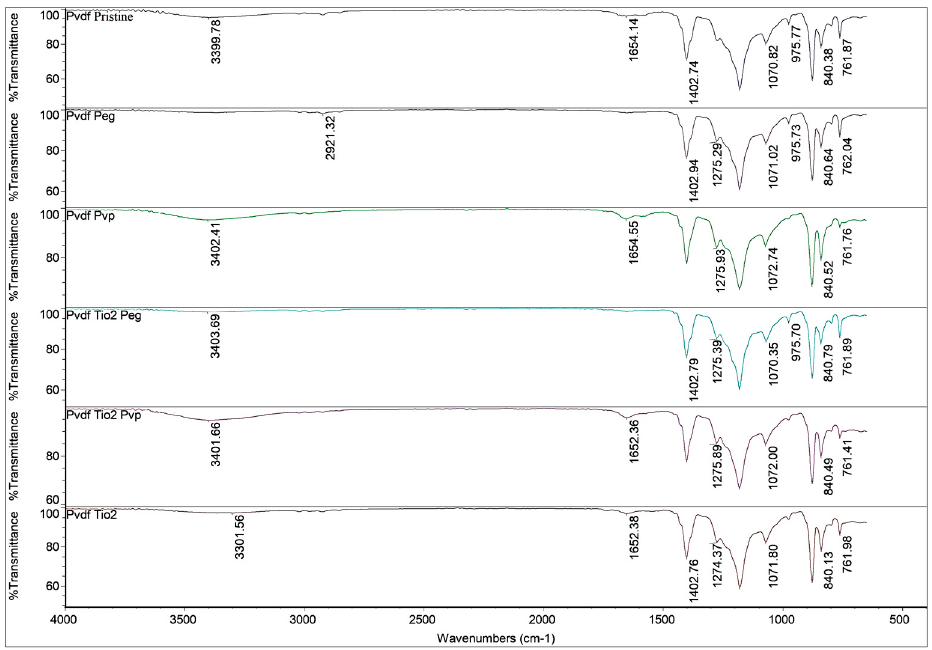
Figure 4. FTIR Spectra of Membranes